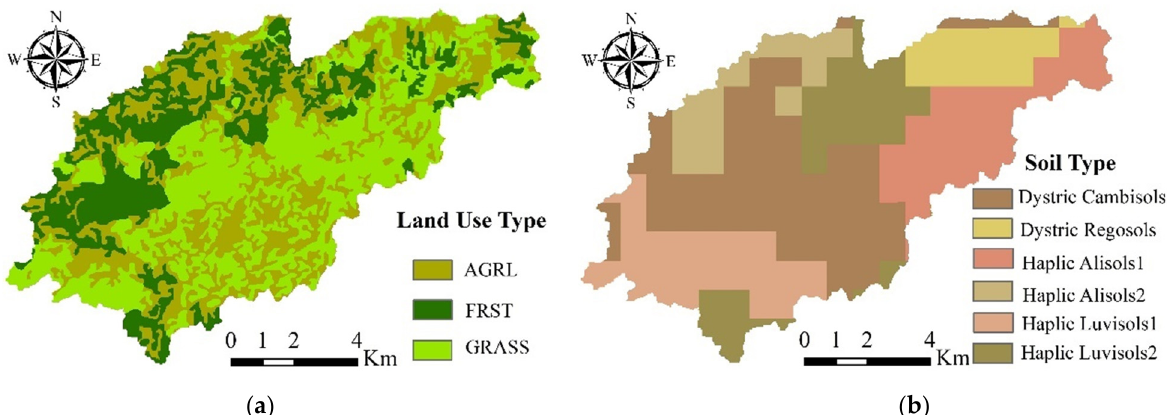
Figure 3. ( a ) Grid data on land use types; ( b ) Grid data on soil types.